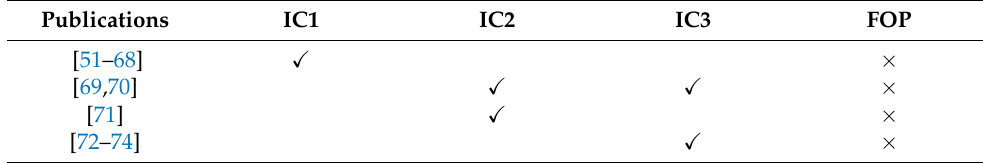
Table 1. The findings of a systematic